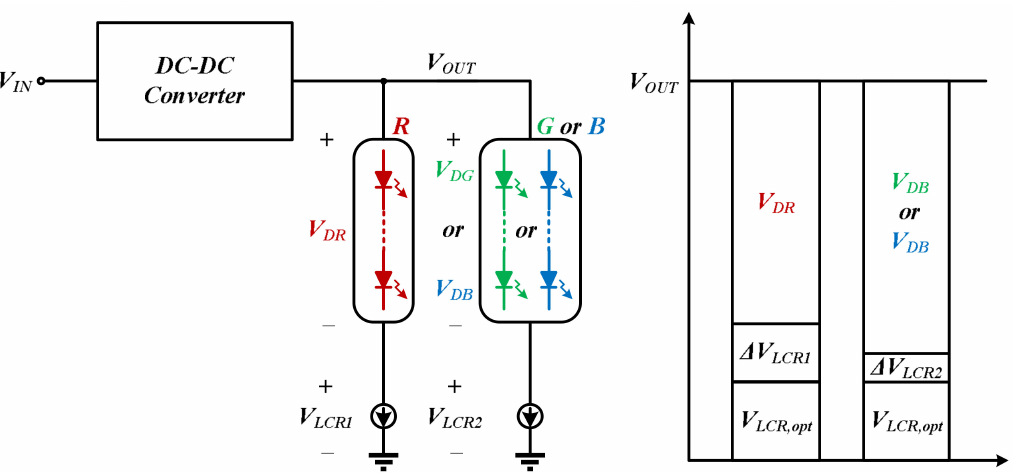
Figure 4. Conventional LED driver.